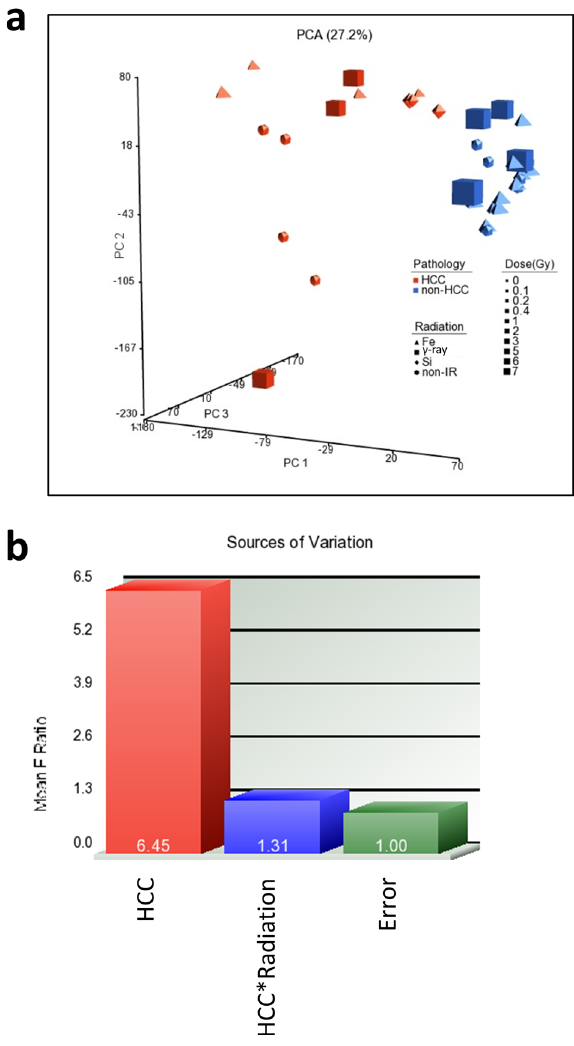
Figure 1. Unsupervised analysis of gene expression profiles in mouse HCC. ( a ) Unsupervised Principle Component Analysis (PCA) indicated distinct gene expression profiles between HCC and non-HCC liver samples. ( b ) Sources of Variation (SOV) analysis showed that HCC contributed to the largest variances. Interactions of HCC and radiation showed a slight increase in F ratios, which indicates modest differences in HCC induced by different radiation